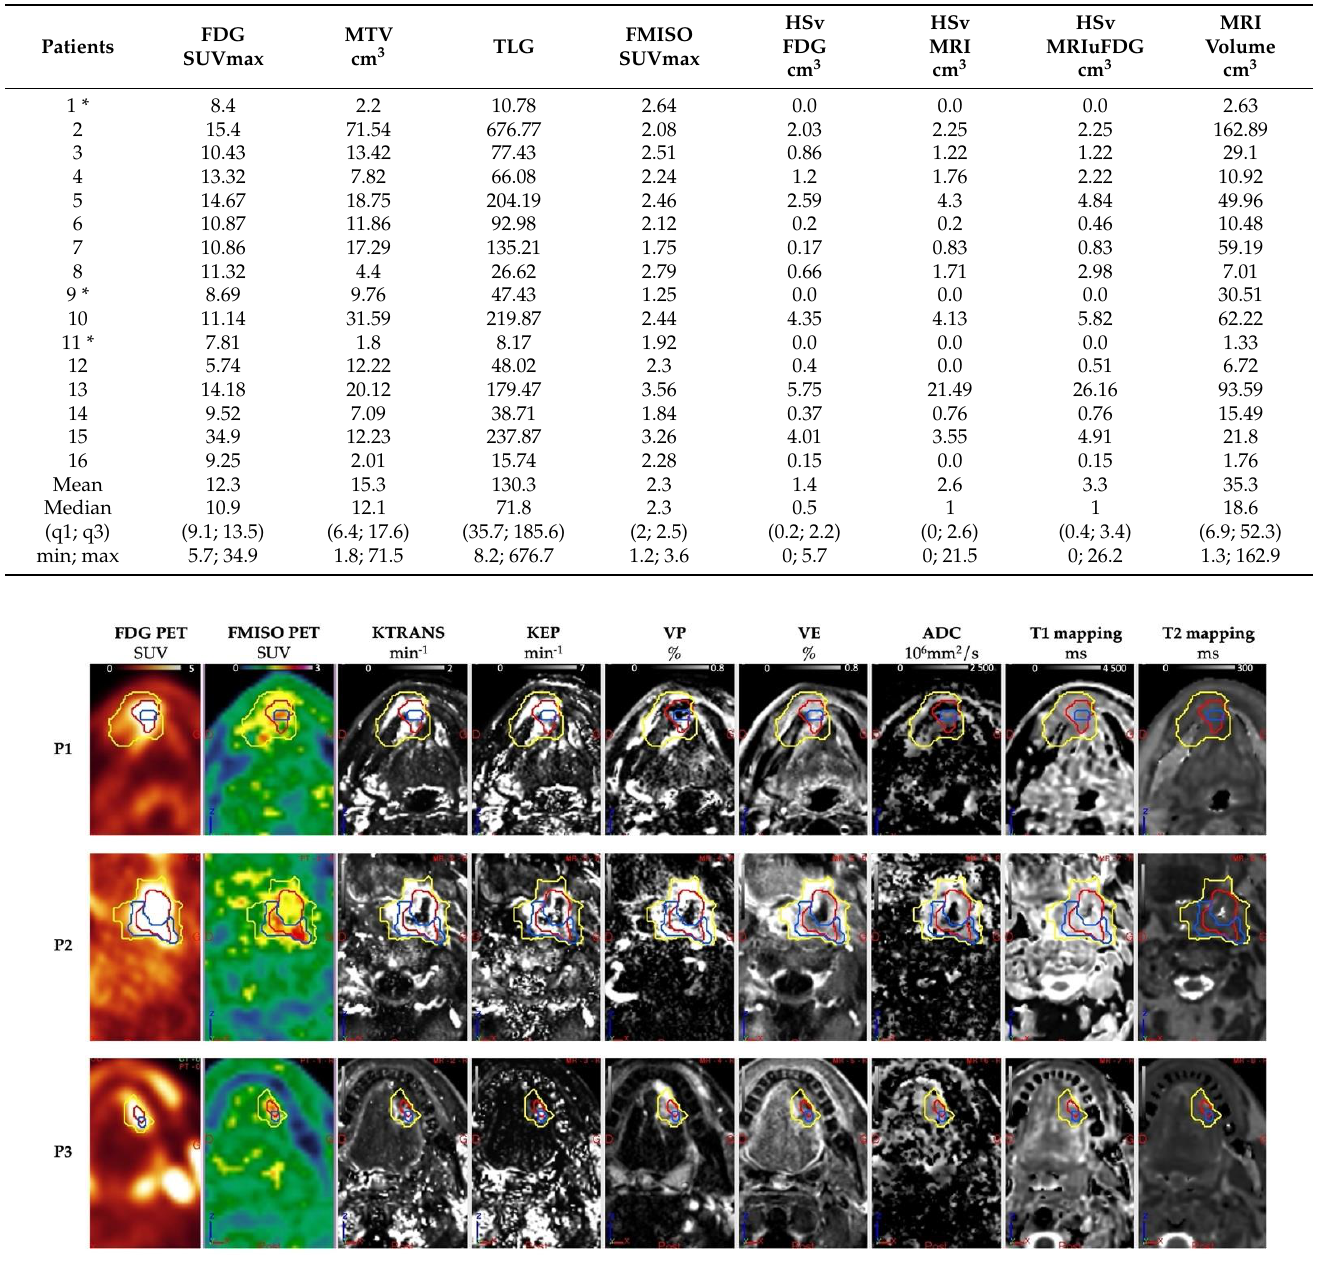
Figure 2. Multimodal PET/CT MRI images obtained from patients 1, 2, and 14 of the RETP8 population. For more details, see patient characteristics in Table 1. MRI tumor segmentation in yellow, FDG PET in red, and FMISO PET hypoxic subvolume in blue on each quantitative PET and MRI series.